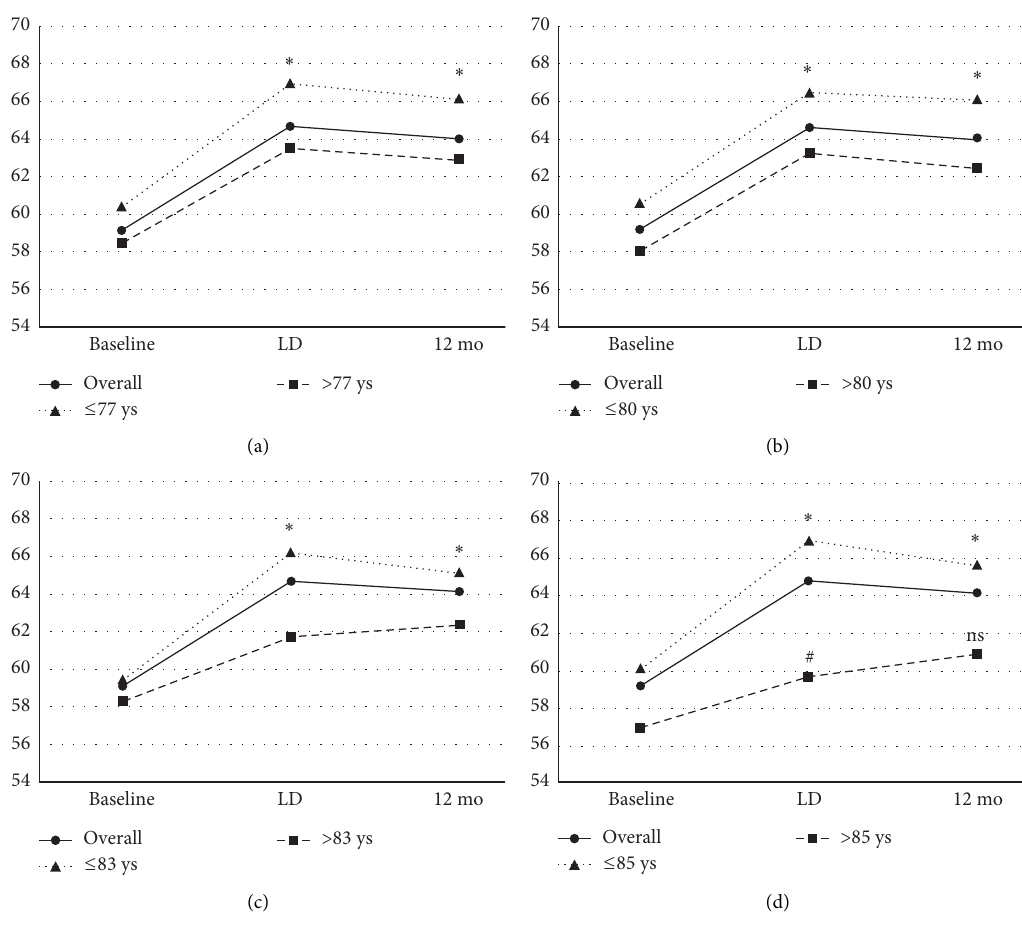
Figure 3: Changes in BCVA (ETDRS letters) by age subgroup. (a) Patients ≤ 77 vs. > 77 years. (b) Patients ≤ 80 vs. > 80 years. (c) Patients ≤ 83 vs. > 83 years. (d) Patients ≤ 85 vs. > 85 years. Mean changes in BCVA after the loading dose (LD) and at the final follow-up were significant ( ∗ ). The eyes belonging to the older subgroups ( > 85 years old), although they presented significant (#) gains in the BCVA means after the LD, there were not significant differences at 12 months (12mo). ns: not significant. Table 3: Best-corrected visual acuity (MD ± SD, number of letters) and gain (number of letters) at the baselines and at final follow-up period (12mo) by age